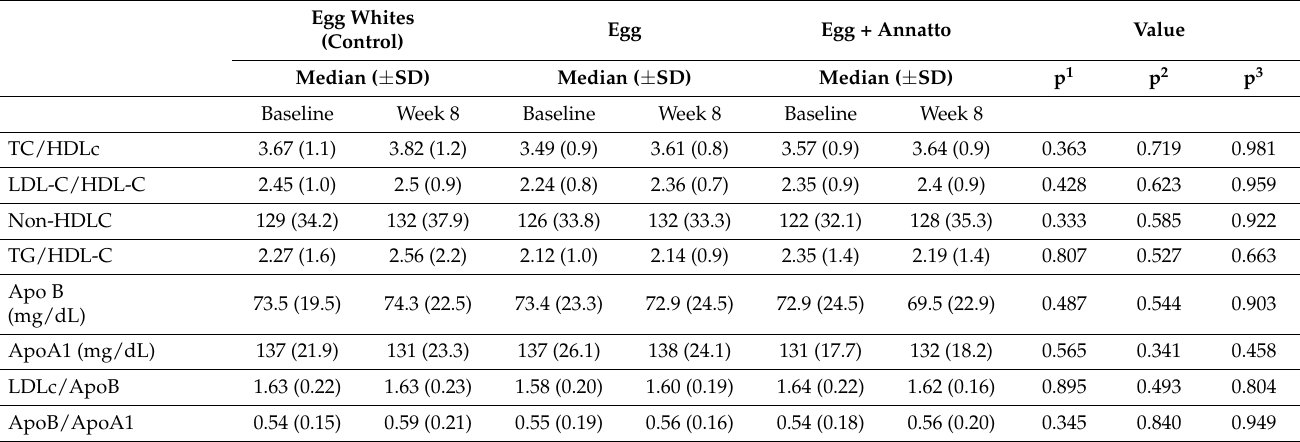
Table 3. Effects on cardiovascular risk indexes and apolipoproteins in the study population according to treatment.